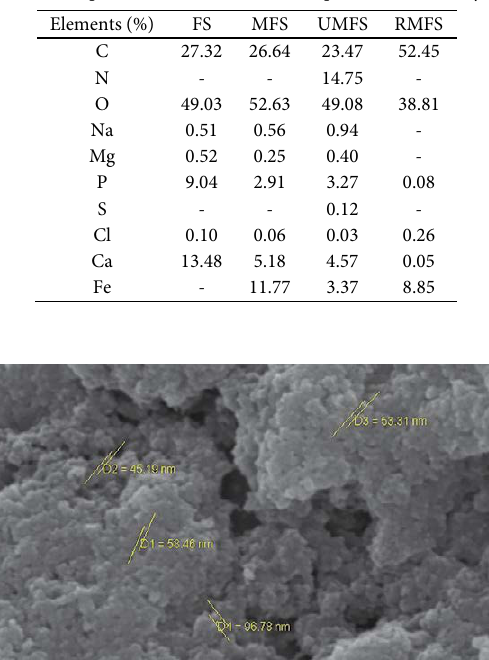
O nanoparticles in FESEM image of MFS. 3 4